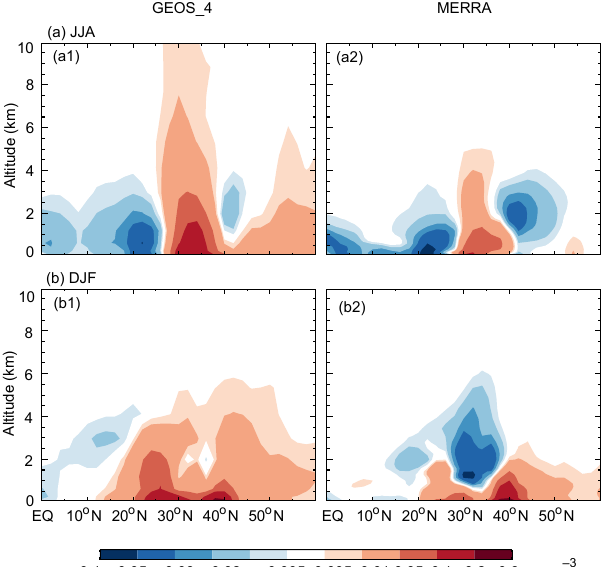
Figure 5. (a) Height–latitude cross section of differences in simu- lated JJA mean BC concentrations (µgm − 3 ) between the 5 weak- est and 5 strongest EASM years during 1986–2006. Plots are aver- aged over a longitude range of 110–125 ◦ E from model simulations VMETG4 (a1) and VMET (a2) . (b) Same as (a) , but for differences in DJF between 5 weakest and 5 strongest EAWM years.